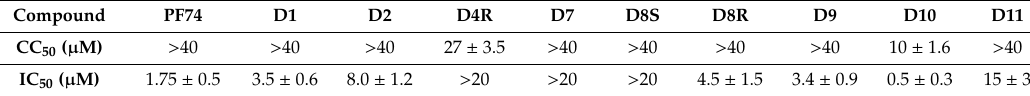
Table 1. Cytotoxicity and inhibitory e ff ect of PF74 and its derivatives.